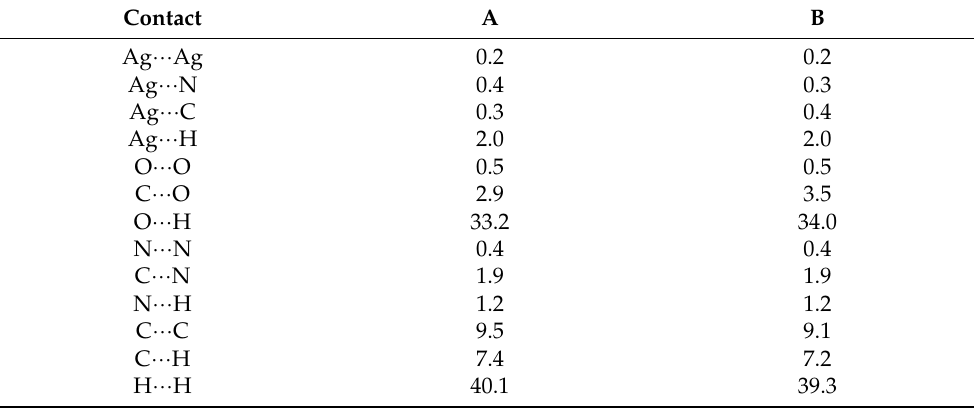
Table 4. The percentages of all contacts in the [Ag(Et3qu) 2 (citrate)]